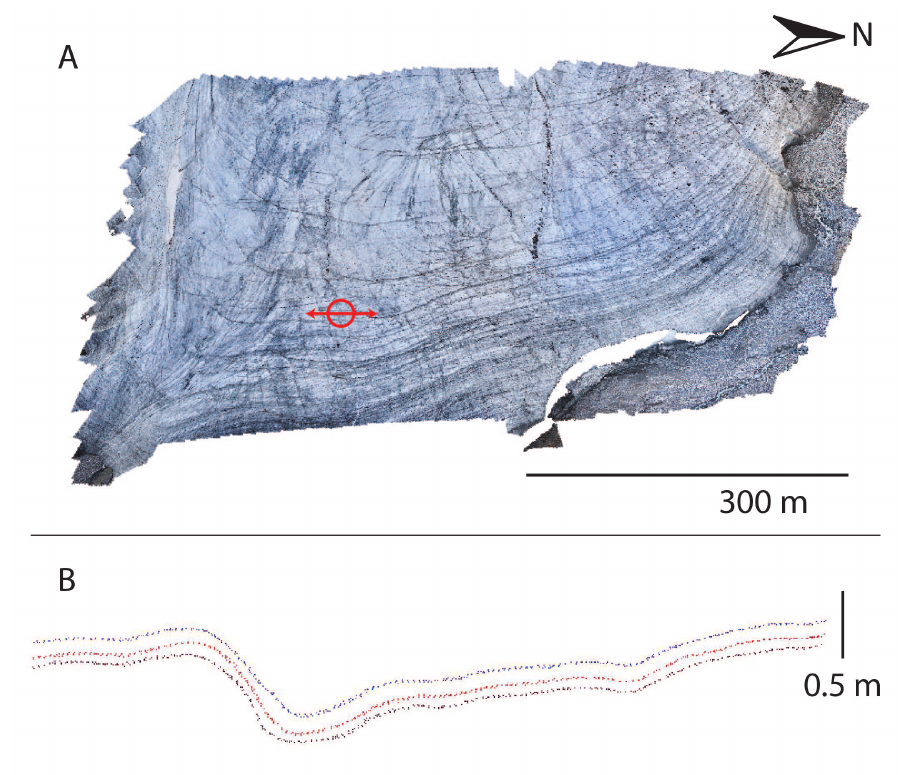
Figure 4. ( A ) The 21 July point cloud constructed in Photoscan is shown in perspective view with RGB colouring. The scale bar is only approximate for the perspective view. The red circle indicates the location of profiles in the lower panel, with the red line showing the profile orientation. ( B ) A west facing view of a cross-section from each point cloud. The uppermost profile is from the 21 July point cloud, with the 23 July points in red in the centre profile. The lowest profile is from the 24 July point